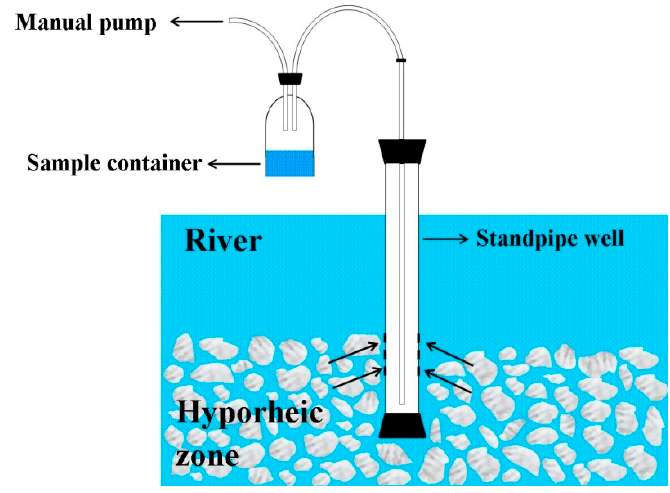
Figure 6. Pump sampling of hyporheic zone (adapted from Biddulph [107]).